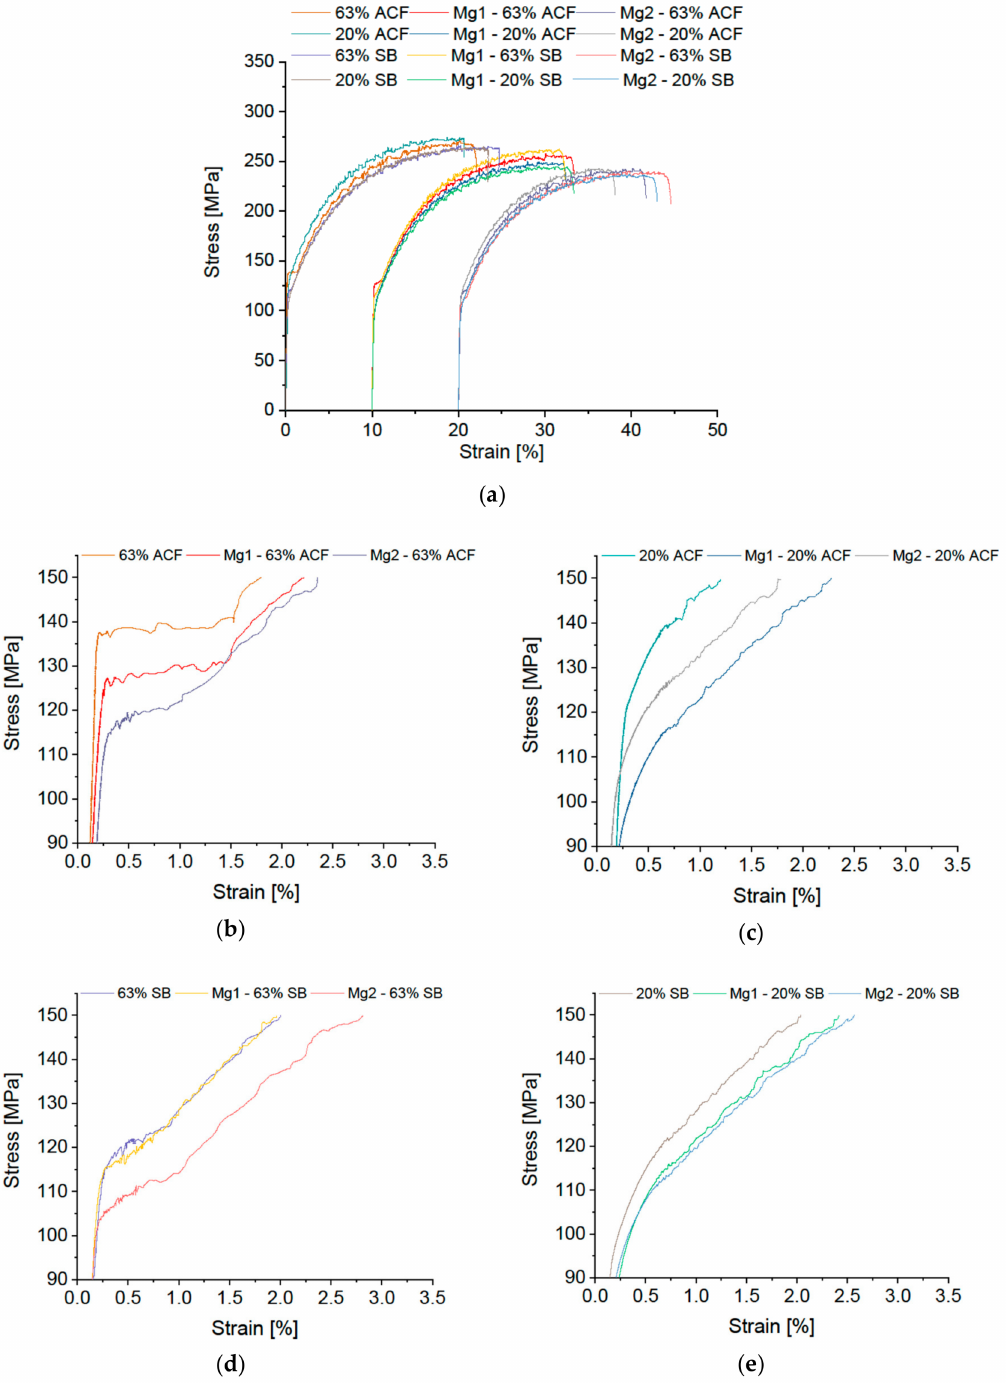
Figure 4. Stress-strain diagram of modified EN AW-5182 with di ff ering Mg content (Standard 4.57%, Mg1 4.16%, Mg2 3.60%). ( a ) Details of Lüders elongation: soft annealing in ACF at 370 ◦ C with ( b ) 63% and ( c ) 20% cold rolling; salt-bath treatment at 500 ◦ C with subsequent water quenching with ( d ) 63% and ( e ) 20% cold